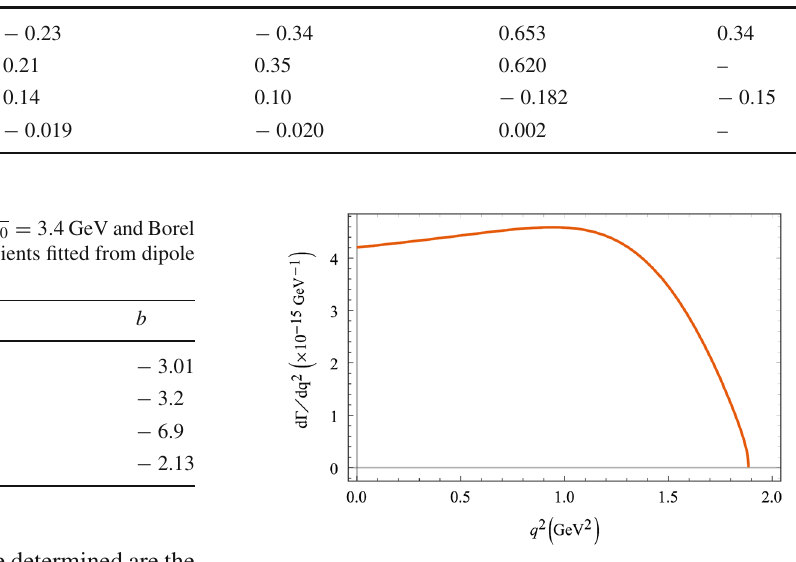
Fig. 3 The differential decay rate dependence on q 2